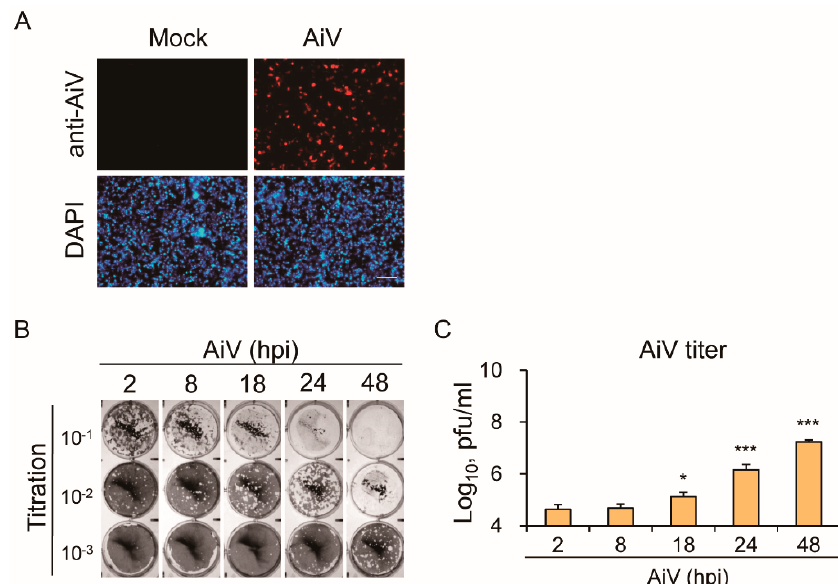
Figure 3. IECs are susceptible to Aichi virus (AiV) infection. ( A ) Immunofluorescence assay of IECs (1 × 10 6 ) with mock infection or AiV infection at MOI of 5 for 24 hpi. AiV-infected IECs detected using the rabbit IgG-anti-AiV VP-1 antibody followed by goat anti-rabbit IgG Alexa 568. AiV-infected cells showed in red fluorescence. Cell nuclei showed in blue fluorescence of DAPI staining. Scale bar: 200 µ m. ( B ) Culture medium AiV-infected IECs harvested for plaque assay, showing plague formation of AiV (10 − 1 ~10 − 3 titration). ( C ) AiV titers counted from plaque assay. Data of plaque titer compared with 2 hpi group showed as means ± SD ( n = 3). Student’s t -test *, p < 0.05; ***, p < 0.001.